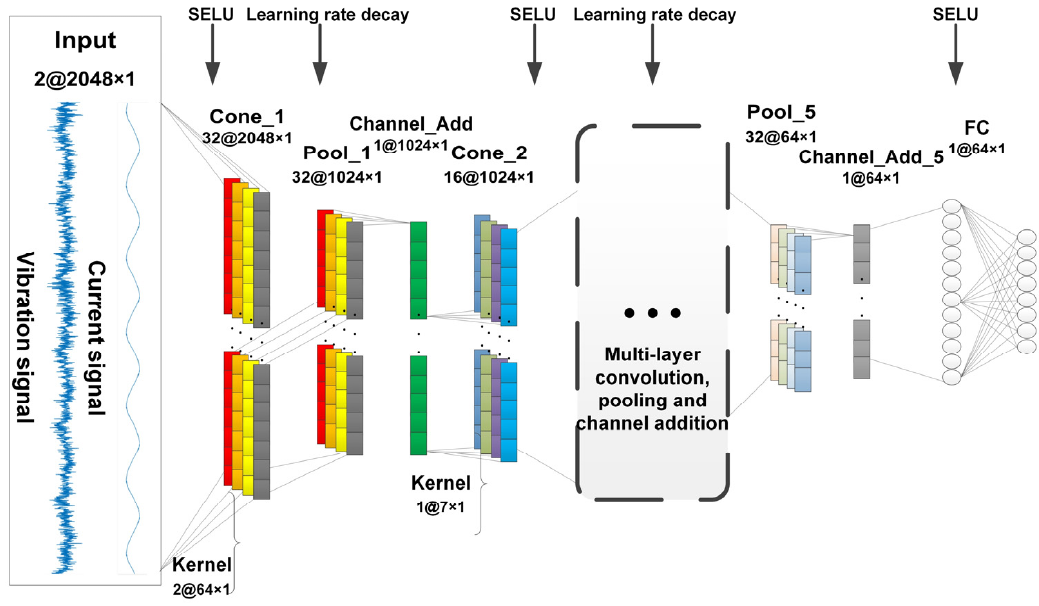
Figure 1. The network structure of MC-DCNN.